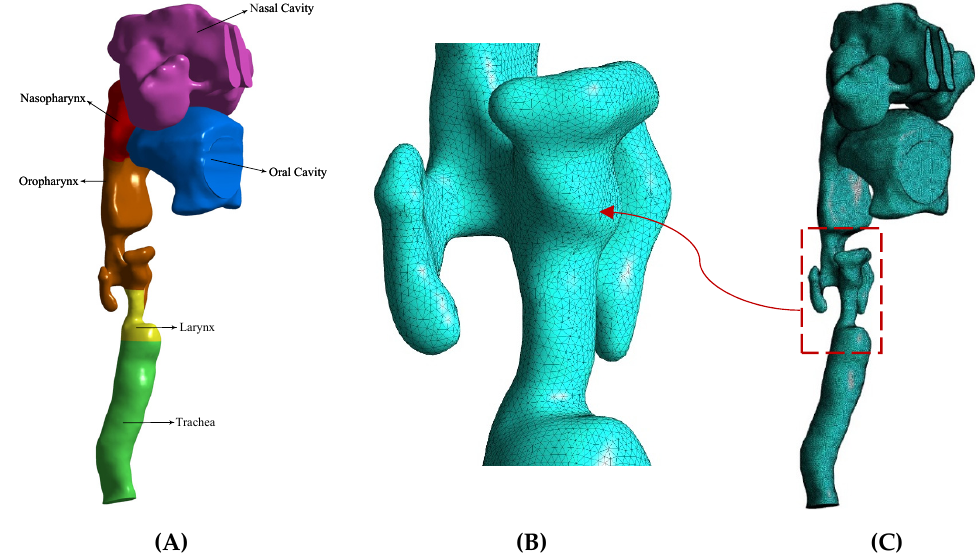
Figure 1. The upper airway of a 70-year-old smoker with laryngeal cancer. ( A ) The anatomical segmentation of the present respiratory system. ( B ) Finer mesh was used in the laryngeal narrowing zone due to the presence of a tumor. ( C ) The grid generation image.